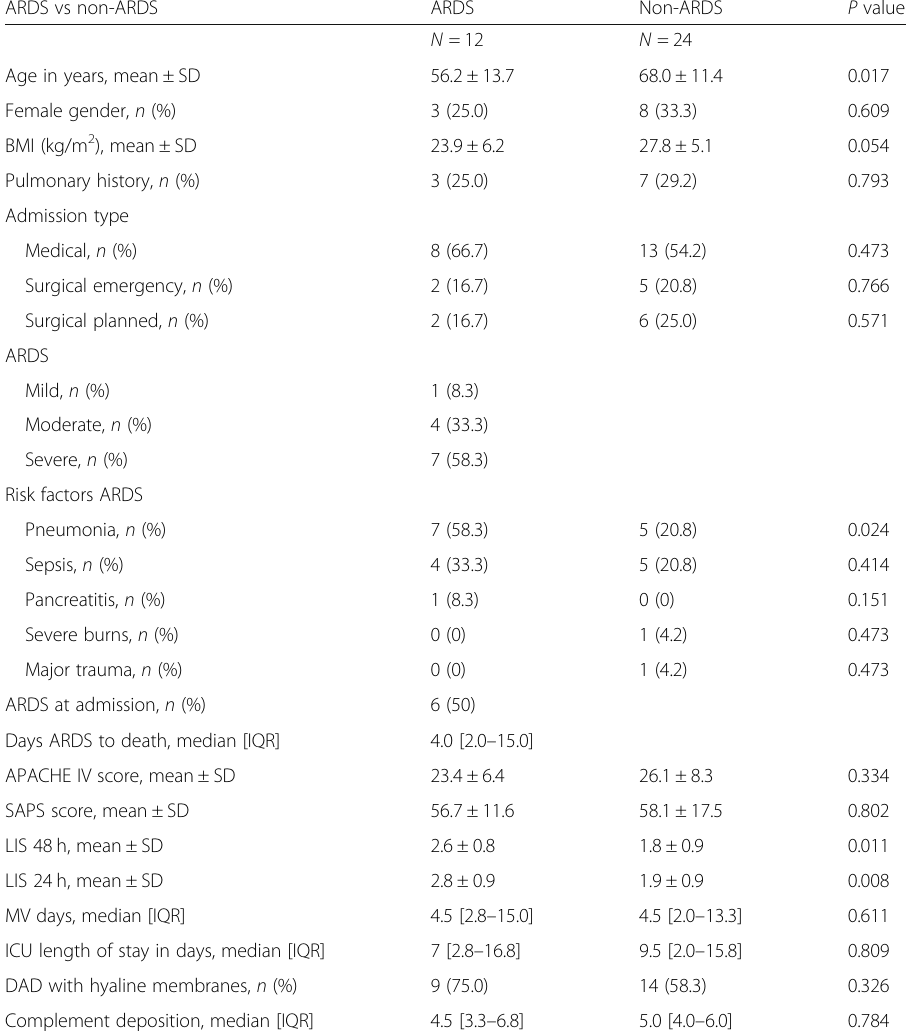
Table 1 Patient